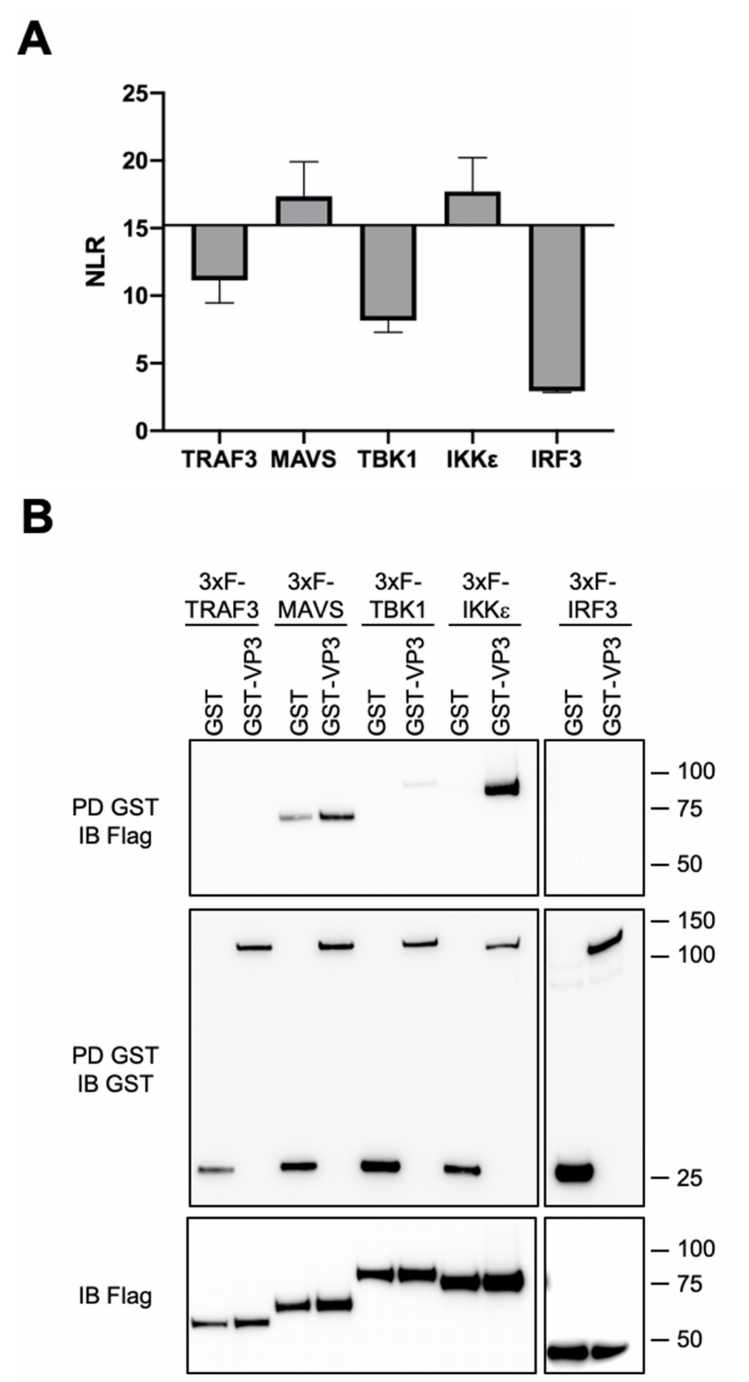
Figure 2. Interaction of VP3 with components of the mitochondrial activating signaling protein (MAVS) complex. ( A ) HEK293T cells were transfected with pSPICA-N2-BTV VP3 and pSPICA-N1- TRAF3, MAVS, TBK1, IKK ε or IRF3. 24 h after transfection, the Gaussia princeps luciferase activity was measured. Representative normalized luminescence ratio (NLR) values for each protein pair are shown. Positive threshold was above 15. ( B ) HEK293T were co-transfected with plasmids encoding Gluathione S-Transferase (GST) alone or fused to BTV-VP3, and pCI-neo-3xFlag encoding 3xFlag tag fused to TRAF3, MAVS, TBK1, IKK ε or IRF3. 24 h after transfection, co-purifications of interferon (IFN) pathway components were assayed by pulldown (PD) using glutathione–Sepharose beads. The presence of overexpressed proteins in cell lysates and precipitated complexes was determined by SDS–PAGE and immunoblotting with 3xFlag and GST